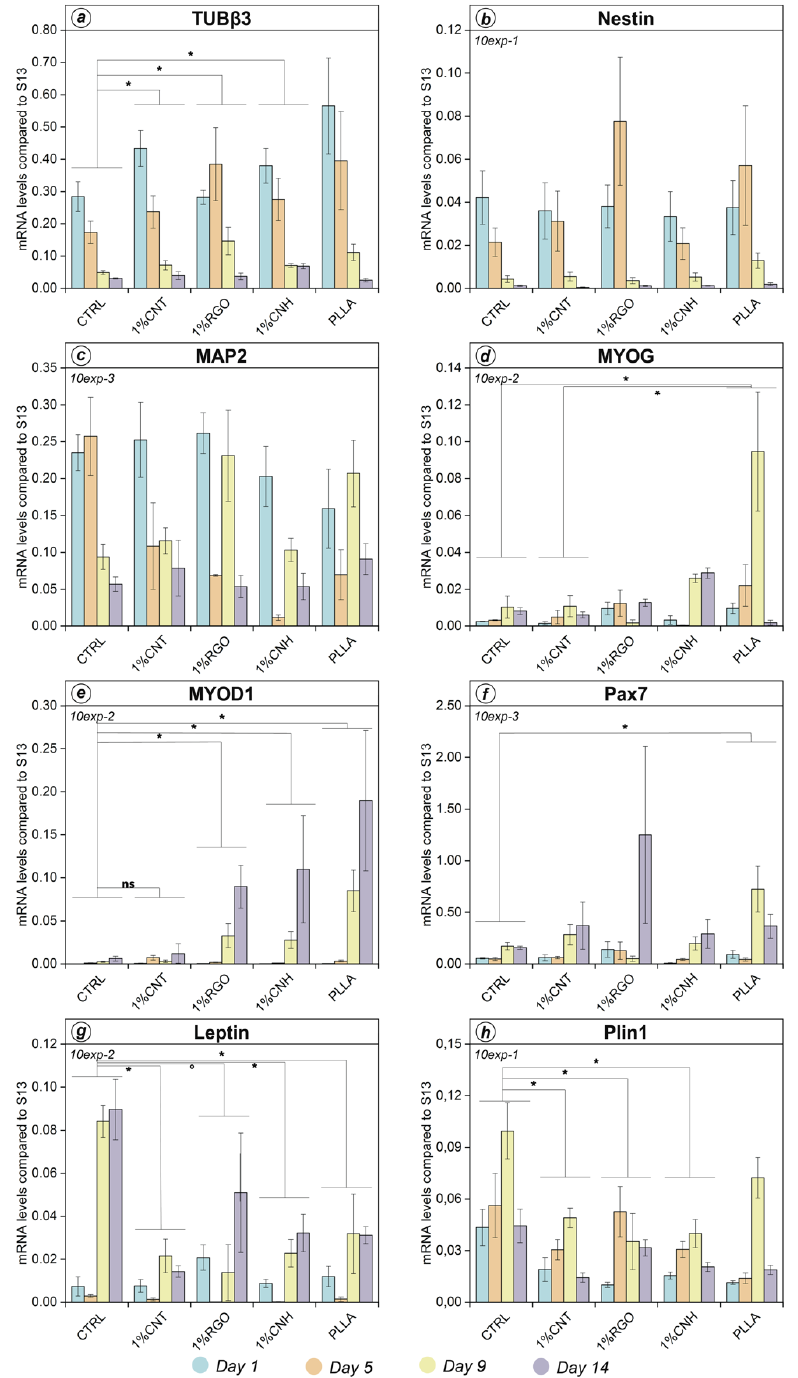
Figure 3. Marker-gene expression during 14 day treatment. Profiled genes in panels a to h are indicated in the upper horizontal bar of each panel. CTRL: differentiative medium w/o scaffold; 1%CNT: 1 wt% CNT@PLLA; 1%RGO: 1 wt% RGO@PLLA; 1%CNH: 1 wt% CNH@PLLA; PLLA: bare PLLA. Control samples were grown in same medium but without scaffolds. Data represent mean ± SEM of three independent experiments performed in duplicate. ° Significance at p < 0.1 among indicated samples; * significance at p < 0.05 among indicated samples.